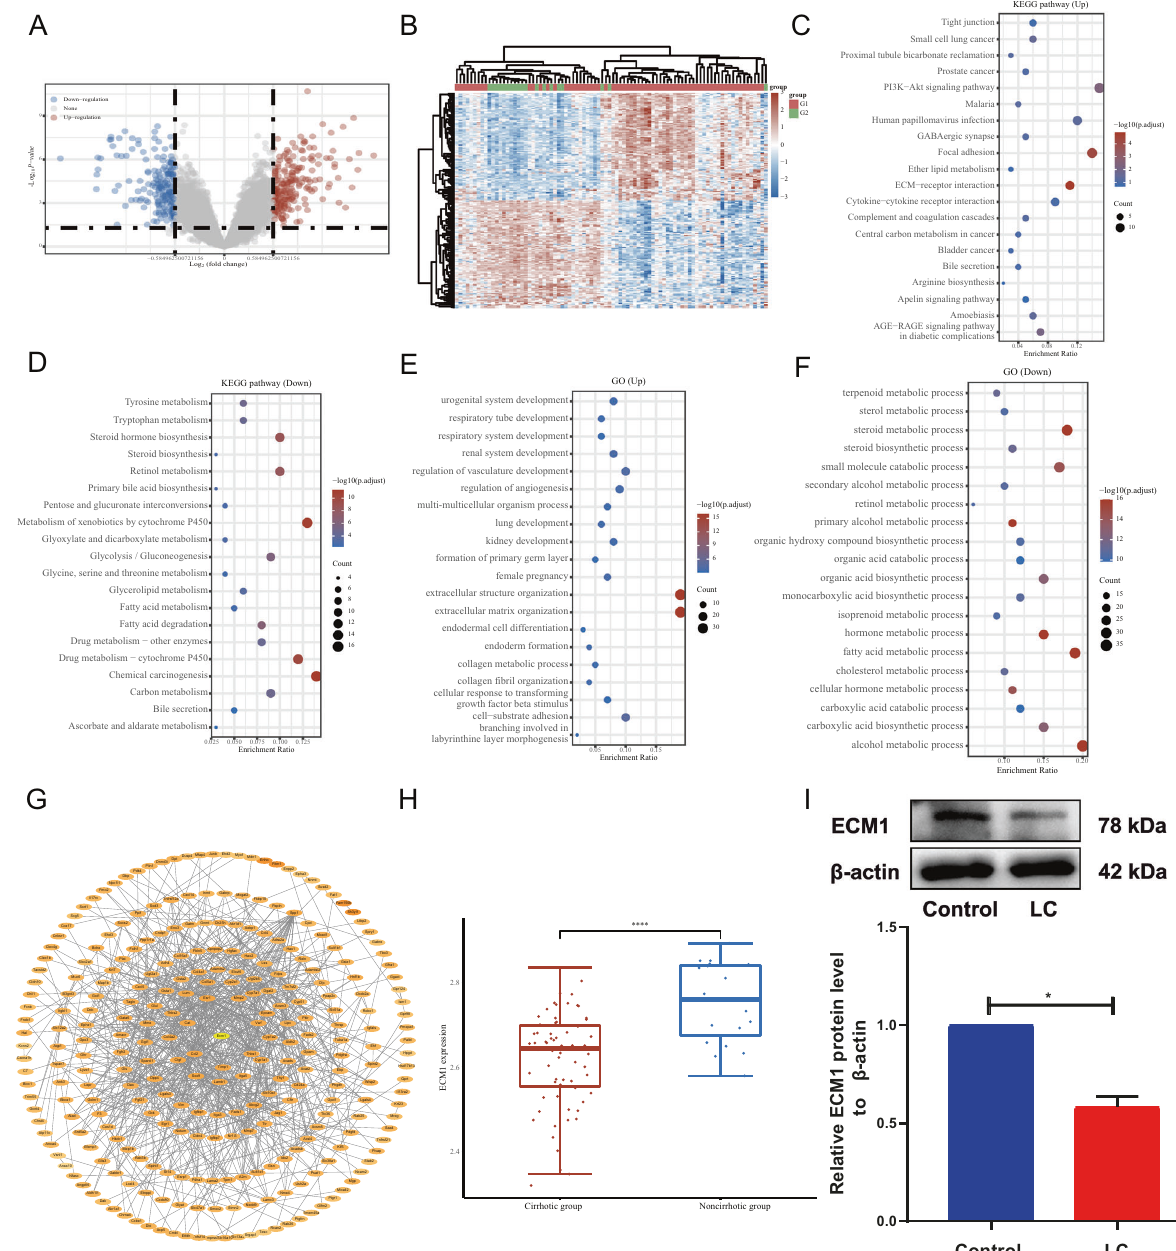
Fig. 2 DEG analysis and identi fi cation of ECM1 as the target gene. A Volcano plot of DEGs in GSE103580. B Heat map of DEGs in GSE103580. G1 represents the cirrhotic group; G2 represents the noncirrhotic group. Red indicates upregulation; green represents downregulation. KEGG pathway analysis of upregulated DEGs ( C ) and downregulated DEGs ( D ). GO enrichment of upregulated DEGs ( E ) and downregulated DEGs ( F ). G Protein – protein interaction networks among the DEGs. H Expression of ECM1 in DEGs. I Western blotting analysis and semiquantitative analysis of ECM1 expression in the control group and the model group. Data are shown as the means ± SDs (* p < 0.05, ** p < 0.01, *** p < vector containing GFP, the target gene ECM1, and the puromycin resistance gene is shown in Fig. 3M. ECM1 was shown to be overexpressed in ECM1-HF-MSCs relative to HF- MSCs and LV-HF-MSCs in qualitative and semiquantitative analyses (Fig. 3N, O).